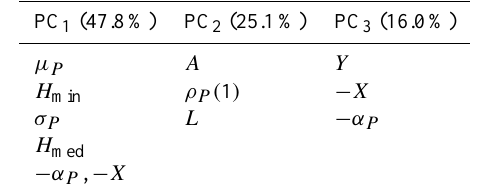
Table 2. Morpho-pluviometric variables with the highest loadings on the first three PCs and total explained variance (in parentheses).